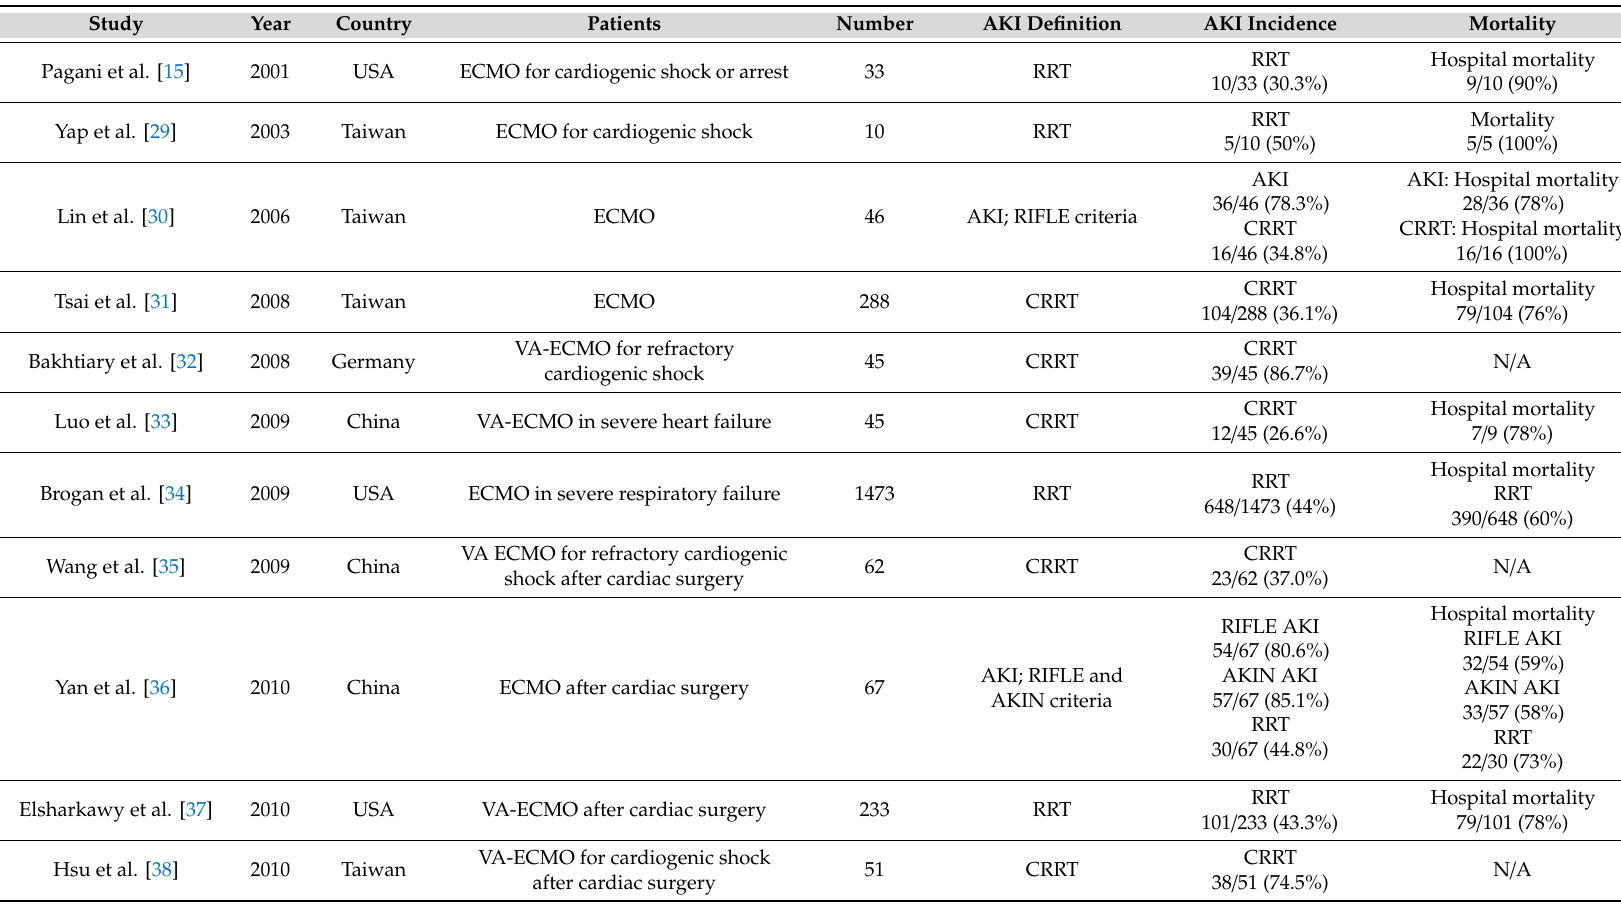
Table 1. Main characteristic of studies included in this meta-analysis of AKI incidence and mortality among patients requiring ECMO